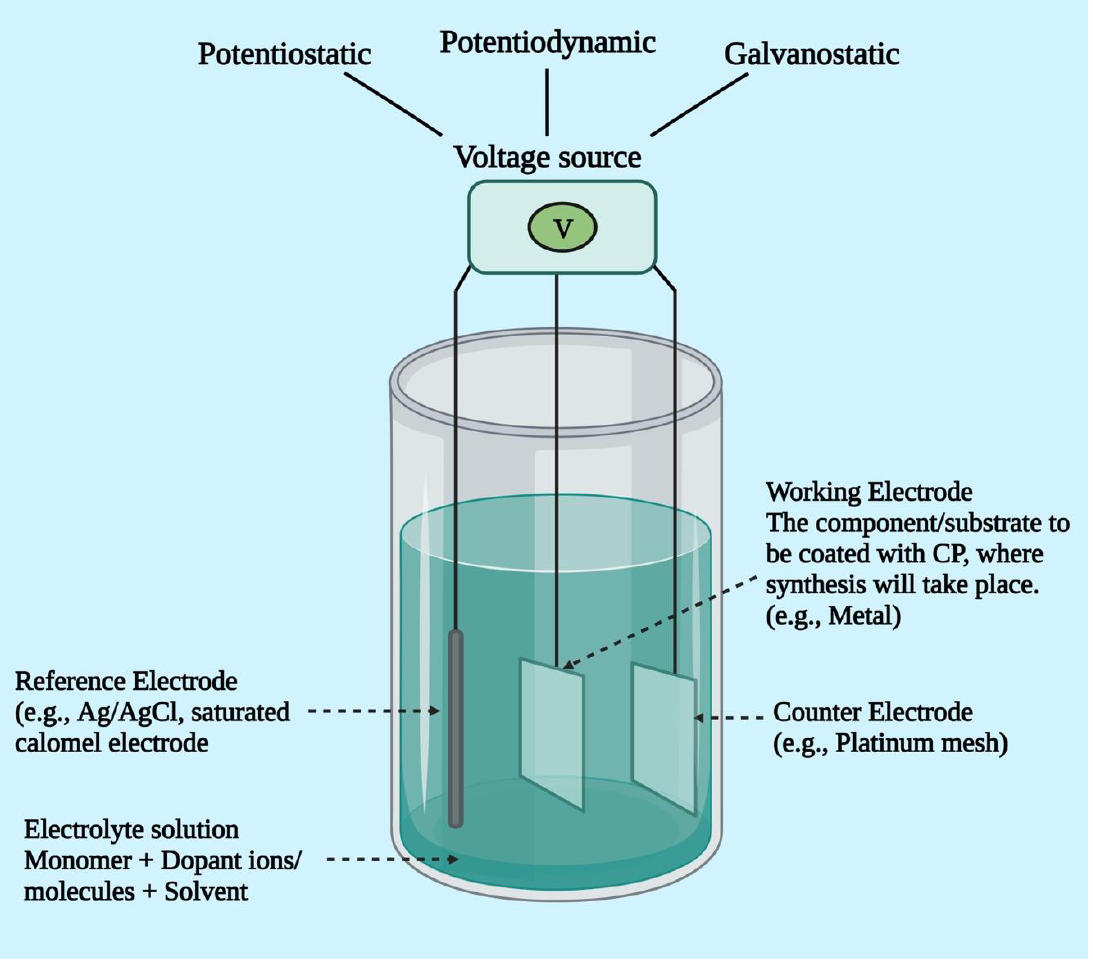
Figure 4. A diagrammatic representation of the electrochemical polymerization set-up.